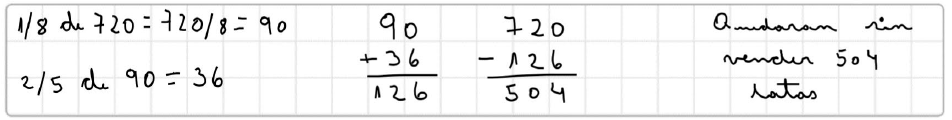
Figure 2. PT21’s written answer to problem FWP2. (Translation of PT21’s solution: “504 cans will remain unsold.”).